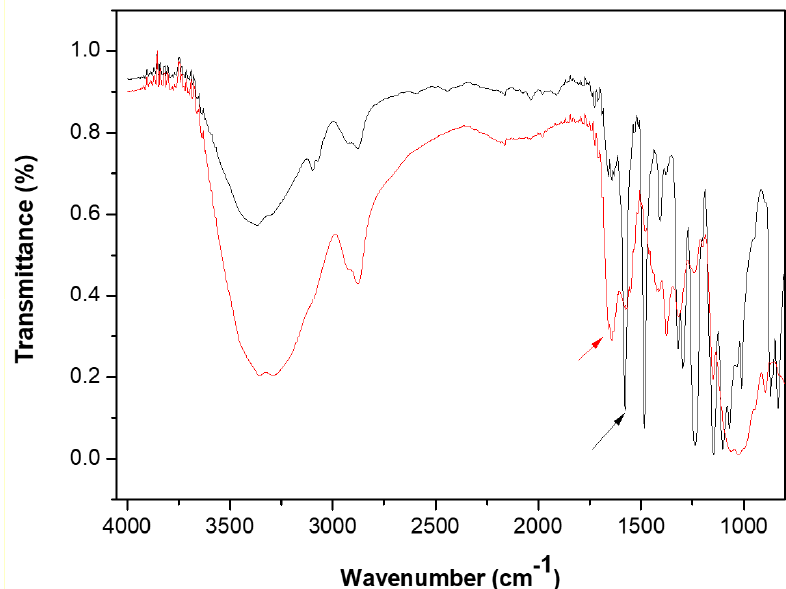
Figure 6. Fourier Transforms Infrared Spectroscopy Attenuated Total Reflectance (FTIR-ATR) spectra of the chitosan modified membranes before and after cross-linking. Black line: chitosan modified membrane before cross-linking; red line: chitosan modified membrane after cross ‐ linking.